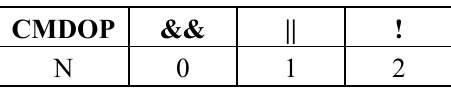
Table 5. Conditional operators.